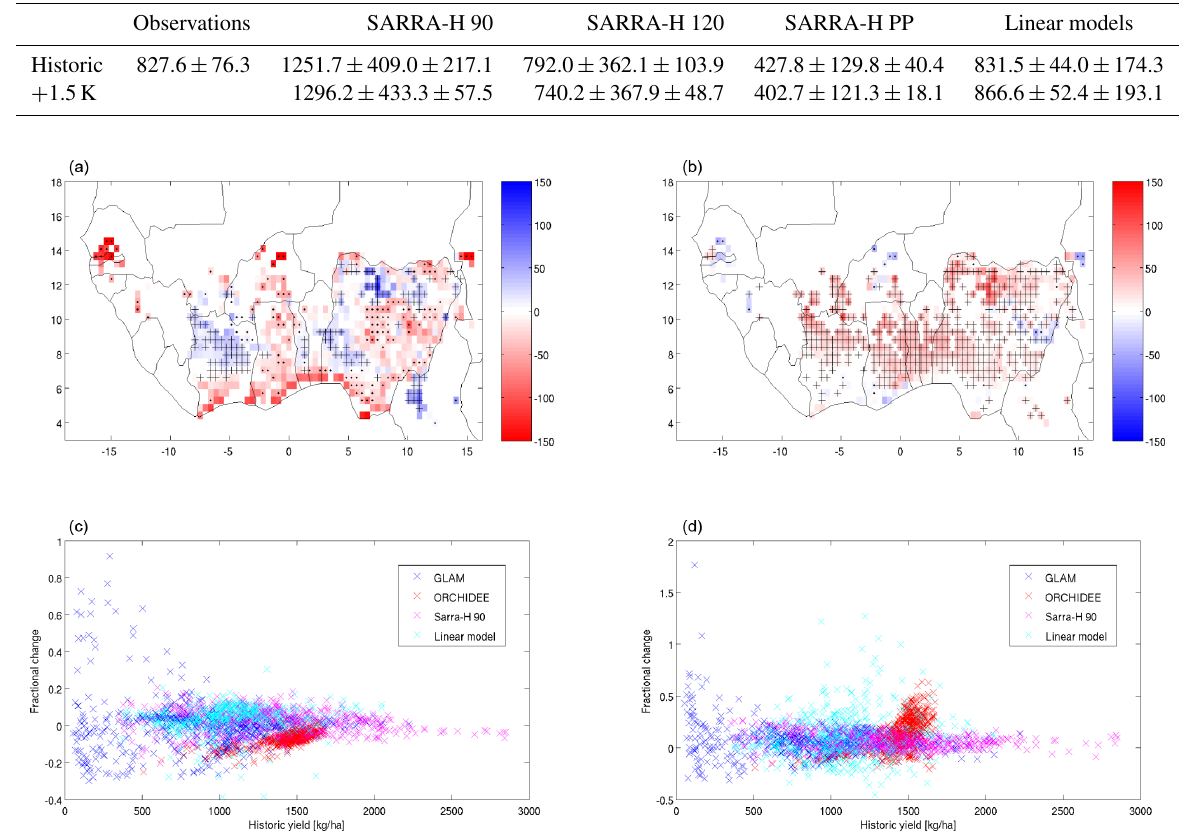
Figure 1. Change in maize yield and yield IAV between the historic and future climates. Panel (a) shows the change in yield, where + indicates that in three crop models the change will be positive and · indicates that in three crop models the change will be negative. Panel (b) is the same as (a) except for IAV instead of yield. The units of the colour bar in the top plots is kilograms per hectare. Panel (c) shows the fractional change in yield against yield for all analysed grid cells. Panel (d) shows the fractional change in yield IAV against yield for all analysed grid